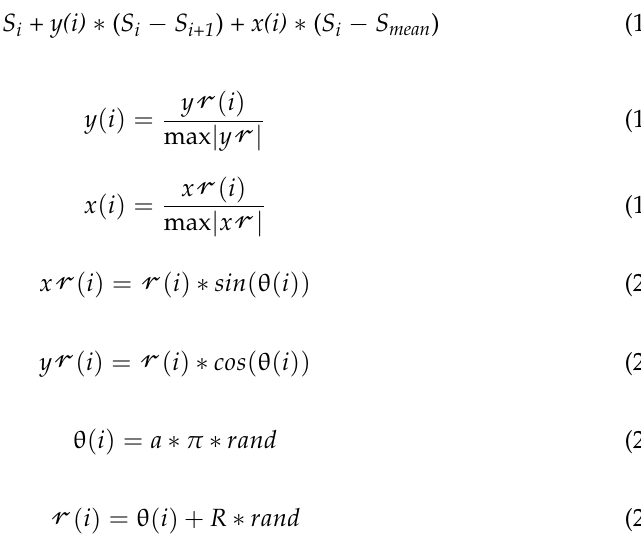
Figure 2. Hunting sequences adopted by the Bald Eagle Search. Swooping Phase